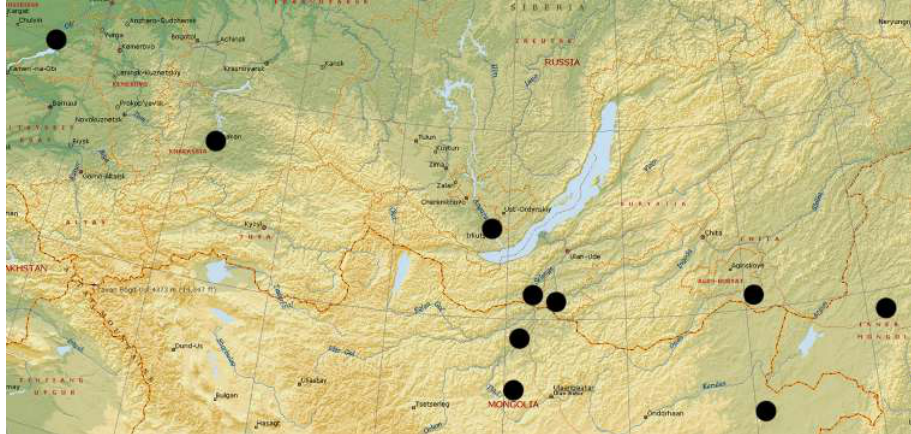
Figure 1. Distribution of Ambrostoma superbum in Description. Body copper-red, with longitudinal green stripes, glabrous, with metallic luster. Bottom greenish. Legs purple. Head capsule hypognathous, short, not constricted behind eyes. Mandibles large, curved. Outer surface of mandibles with dense punctures and pubescence. Labrum free, transverse. Anteclypeus present. Clypeus short, transverse. Eyes qyute small, transverse-oval, finely faceted, weakly convex. Forehead wide, about 2.5 times as wide as head width before eyes, flattened, finely punctate, with middle groove. Temples very short. Antennae inserted before eyes, filiform and long, extends over humeri. Pronotum slightly dilated in front of middle region, with lateral depression and with weakly arcuate sides, about 0.6 times as long as wide at apex, about 0.5 times as long as wide in middle and at base, finely punctate. Basal edge of pronotum immarginate. Distances between punctures much larger than their diameters. Disc of pronotum moderately convex. Base about 0.8 times as narrow as elytral base. Scutellum distinct, semi-oval, about 0.8 times as long as wide. Elytra subparallel-sided, with transverse depression and with weak humeri, double striate, about 1.3 times as long as wide at base, about 1.1 times as long as wide in middle and at apical fourth, about 3.2 times as long as pronotum, without well-defined post-median violaceous patch surrounded by green. Greatest width behind middle. Interspaces between elytral striae finely and densely punc- tate. Epipleuron distinct, with setae. Precoxal part of prosternum about 0.7 times as long as procoxal cabity lenghth. Procoxal cavities transverse, distinctly separated, open behind. Apex of prosternal process emarginated. Metaventrite slightly shorter than metacoxal lenghth, flattened. Metanepisterna narrow, about 8 times as long as wide in middle. Wings developed. Abdomen convex, with free ventrites. Ventrite 1 equal in length to metacoxal lenghth. Ventrite 2 about 0.7 times as long as ventrite 1. Ventrites 3 and 4 equal in length. Ventrite about 0.7 times as long as ventrite 2. Ventrite 5 two ttimes as long as ventrite 4, with paired deep sinuation in males and almost rounded at apex in females. Legs long. Femora thickened. Tibiae quite